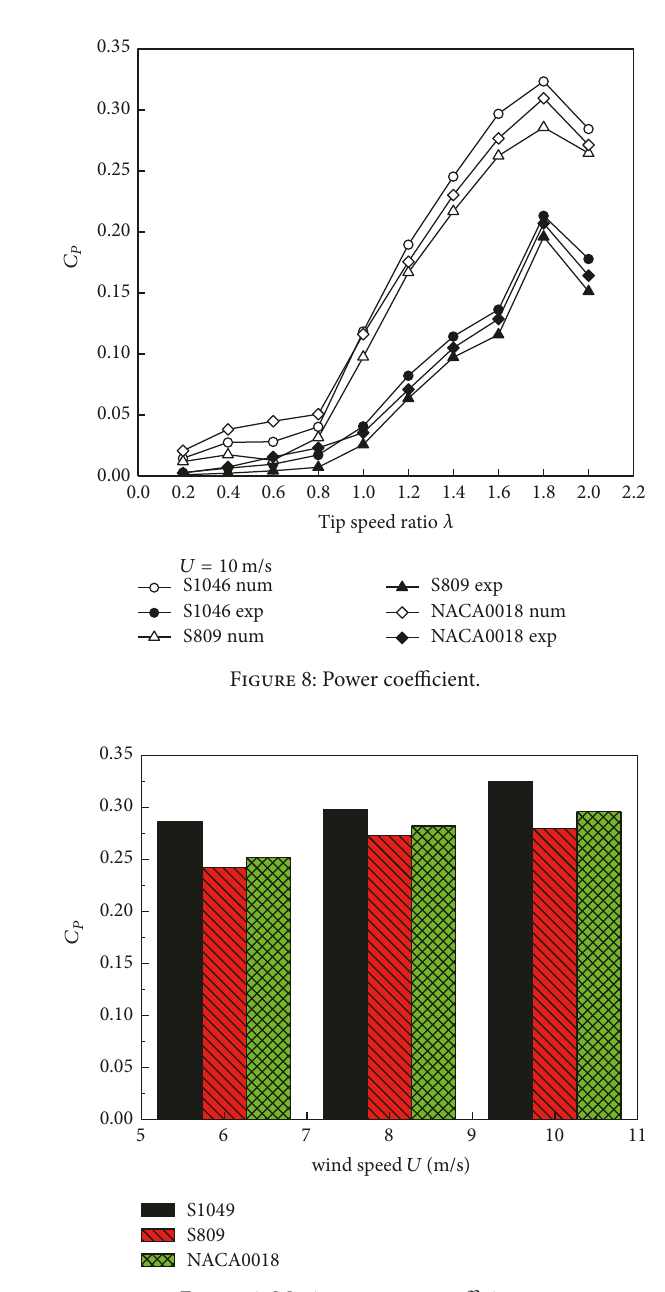
Figure 9: Maximum power